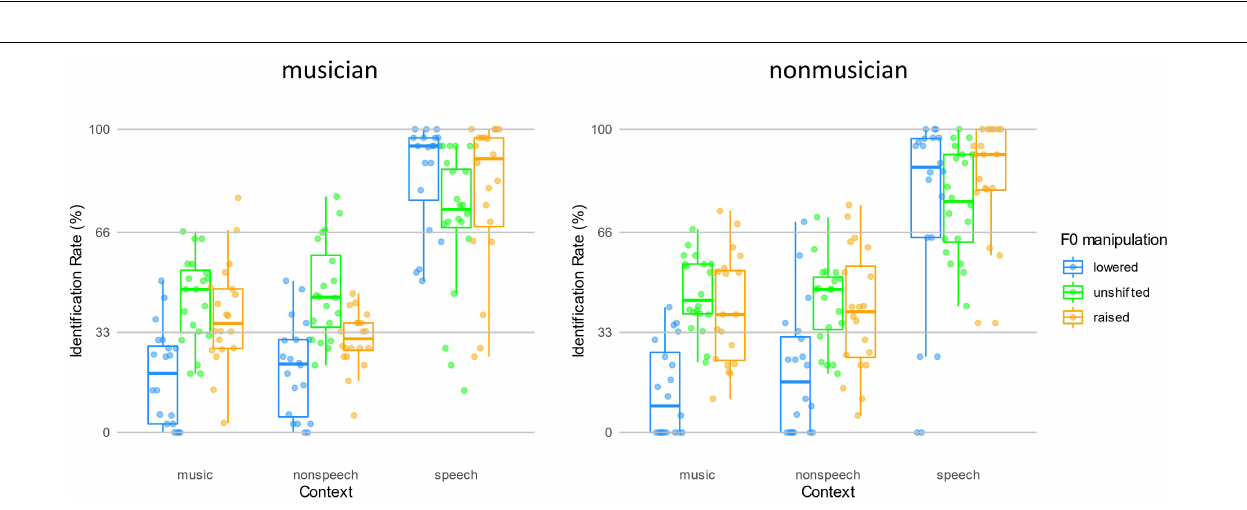
FIGURE 3 | The perceptual height of the targets following three contexts with F0 manipulations in two groups.